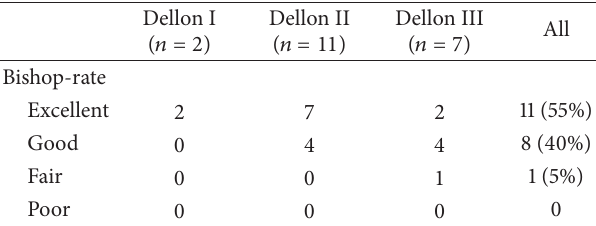
Table 3: A modified Bishop scoring